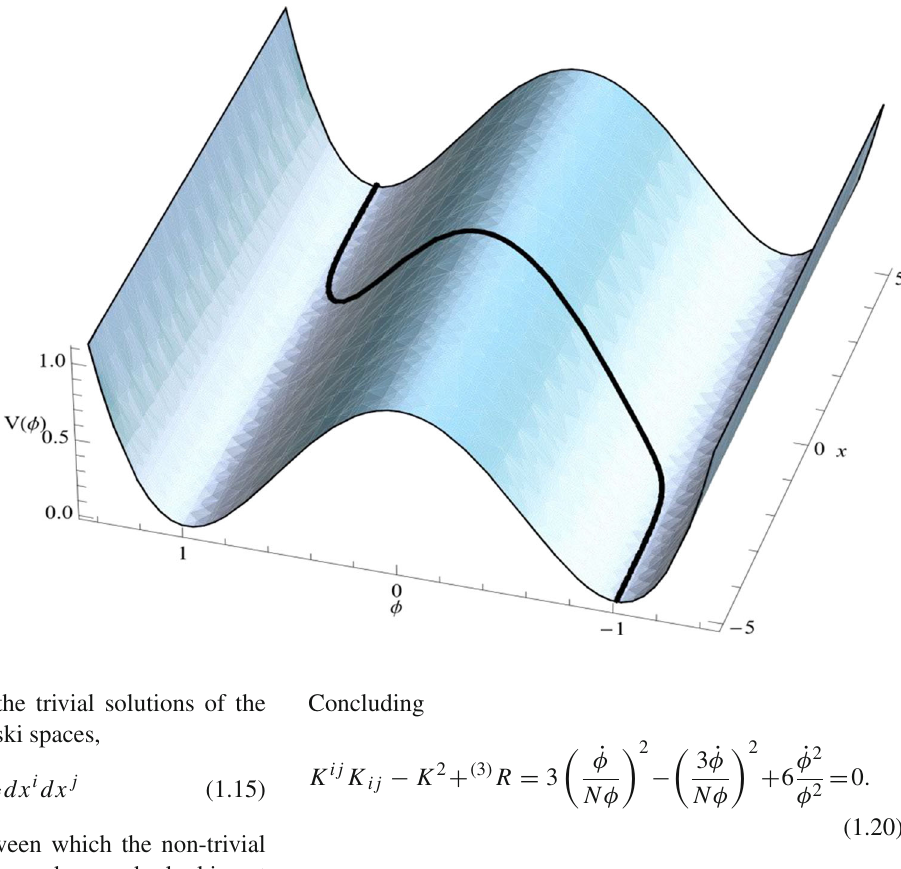
Fig. 1 Illustration of the manifold’s scale factor φ( t ) for t 0 = 0 as a one-dimensional field configuration interpolation between the two minima of k (φ) , which is proportional to the scalar